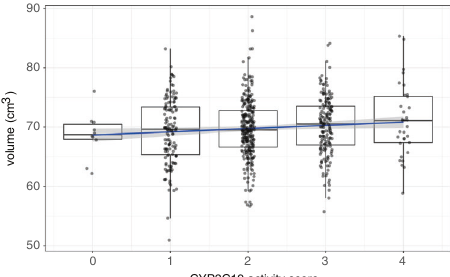
Fig. 2 Global subcortical volumes with respect of CYP2C19 activity scores, adjusted for sex, age, and site. In contrast to Fig. 1, voumes increase with activity scores. Table 2. Effect of CYP2C19 activity score on subcortical volumes.